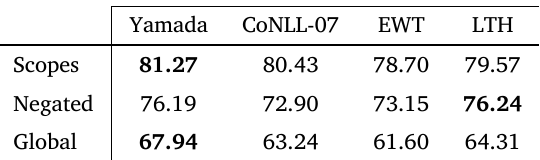
Performance of the NR system with gold cues on the Conan Doyle development set for different dependency formats using the Mate parser, reproduced from Elming et